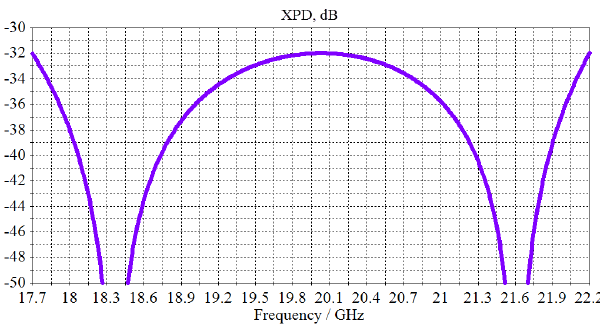
FIGURE 8. XPD (in dB) of the optimized Ka-band waveguide iris polarizer